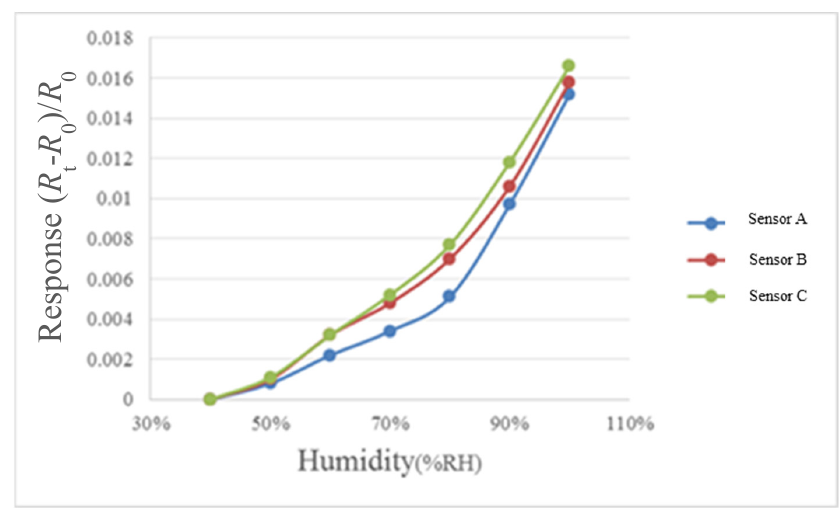
Figure 12. 70 °C relative humidity correction curve diagram. Figure 12. 70 ◦ C relative humidity correction curve diagram.